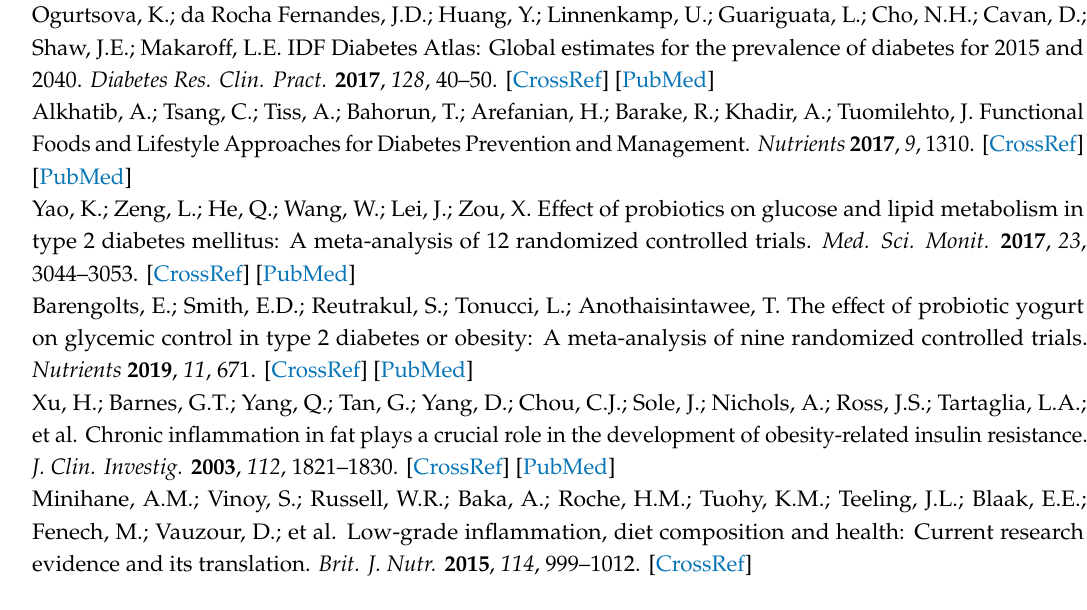
Table S1: CONSORT 2010 checklist of information to include when reporting a randomised